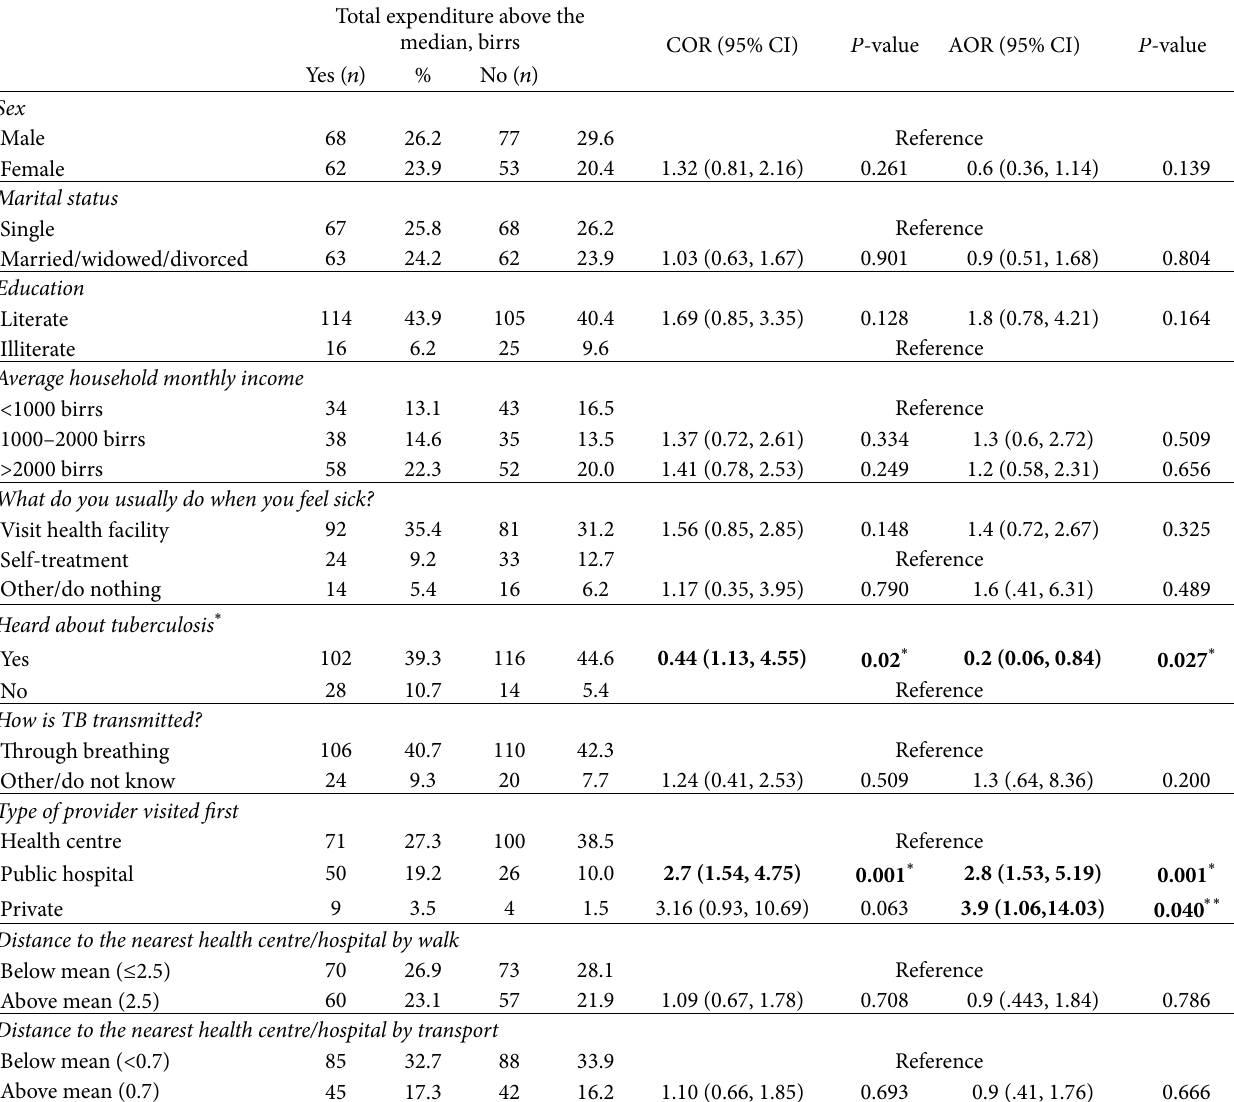
Table 5: Bivariate and multivariate analysis of expenditure for TB services by socio demographic characteristic participants TB patients, at health centres in Addis Ababa, 2017: 𝑛 = 260